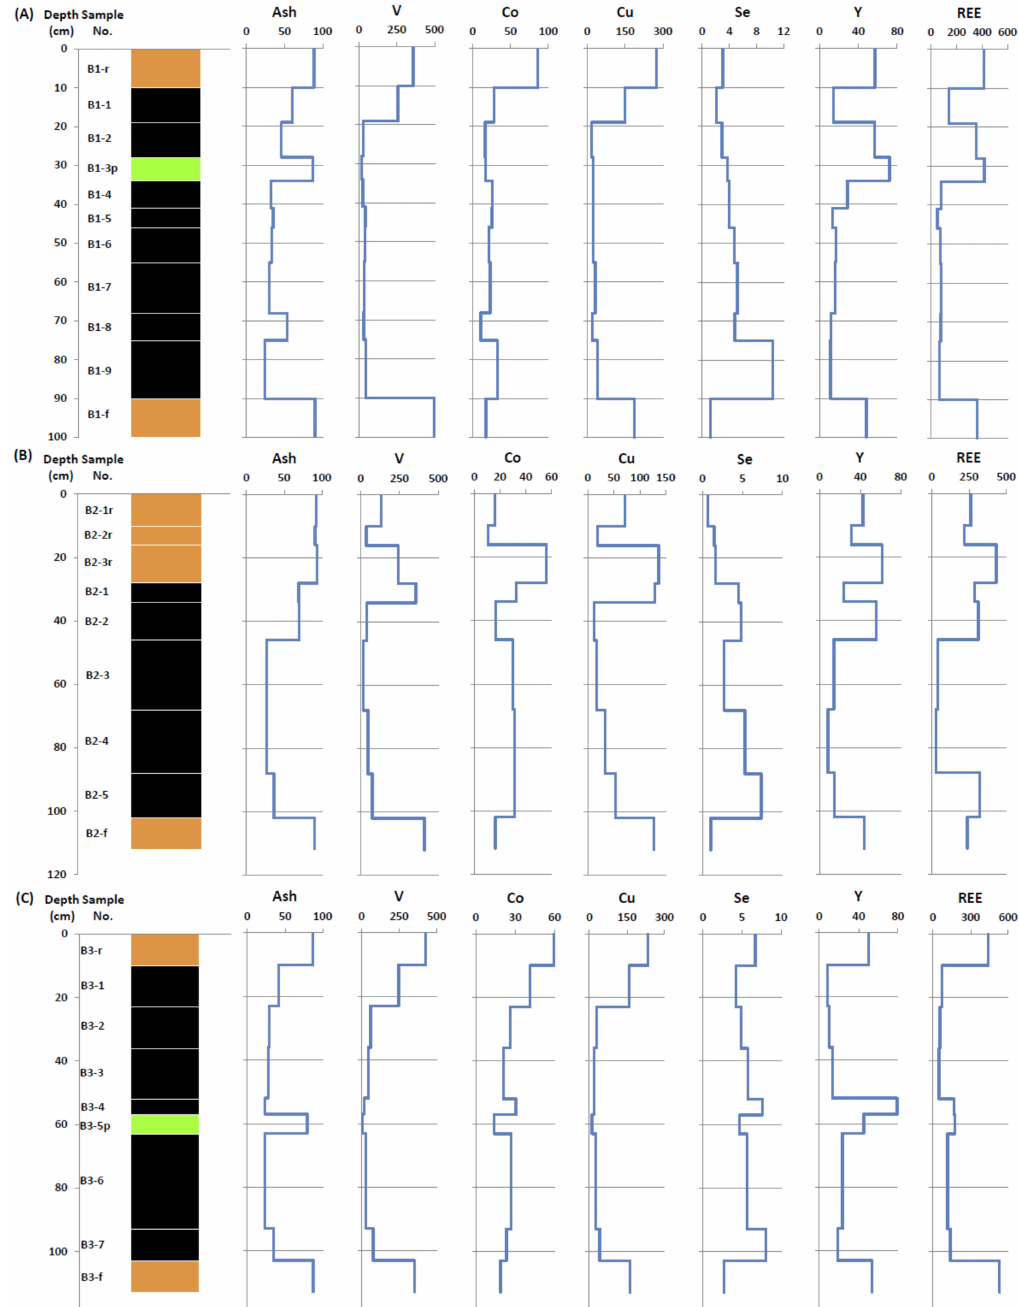
Figure 23. Variations of ash yields (%) and concentrations ( µ g/g) of V, Co, Cu, Se, Y, and REE through B1, B2, and B2 layers. The legend is the same as that in Figure 22. ( A ), B1 layer. ( B ), B2 layer. ( C ), B3